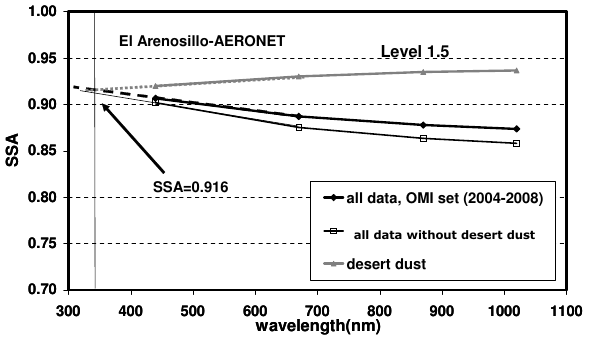
Fig. 7. The mean values of SSA as function of wavelengths (level 1.5) for the period 2004–2008. The SSA spectral mean value when desert dust data are removed from the total and the spectral SSA for desert dust aerosol (this behaviour is the same as that given by level 2 SSA).